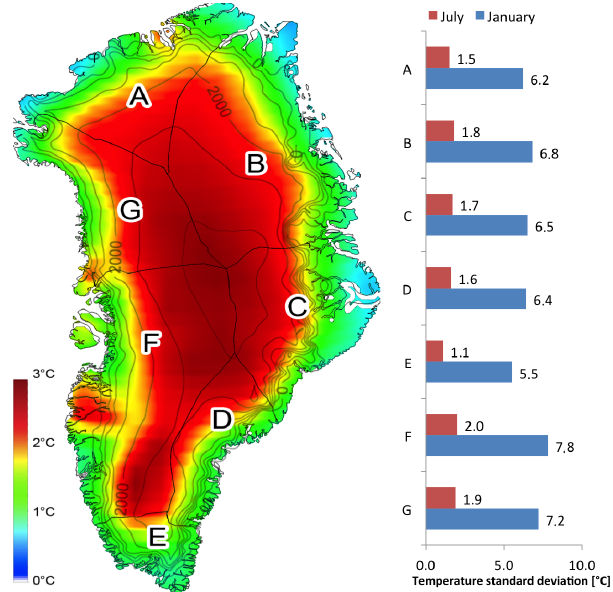
Fig. 1. Map of daily temperature standard deviation (SD), σ (see Eq. 1), derived for the July month using ERA-40 temperature fields across Greenland (1958–2001). The bars on the right show July and January SD values averaged over major drainage basins